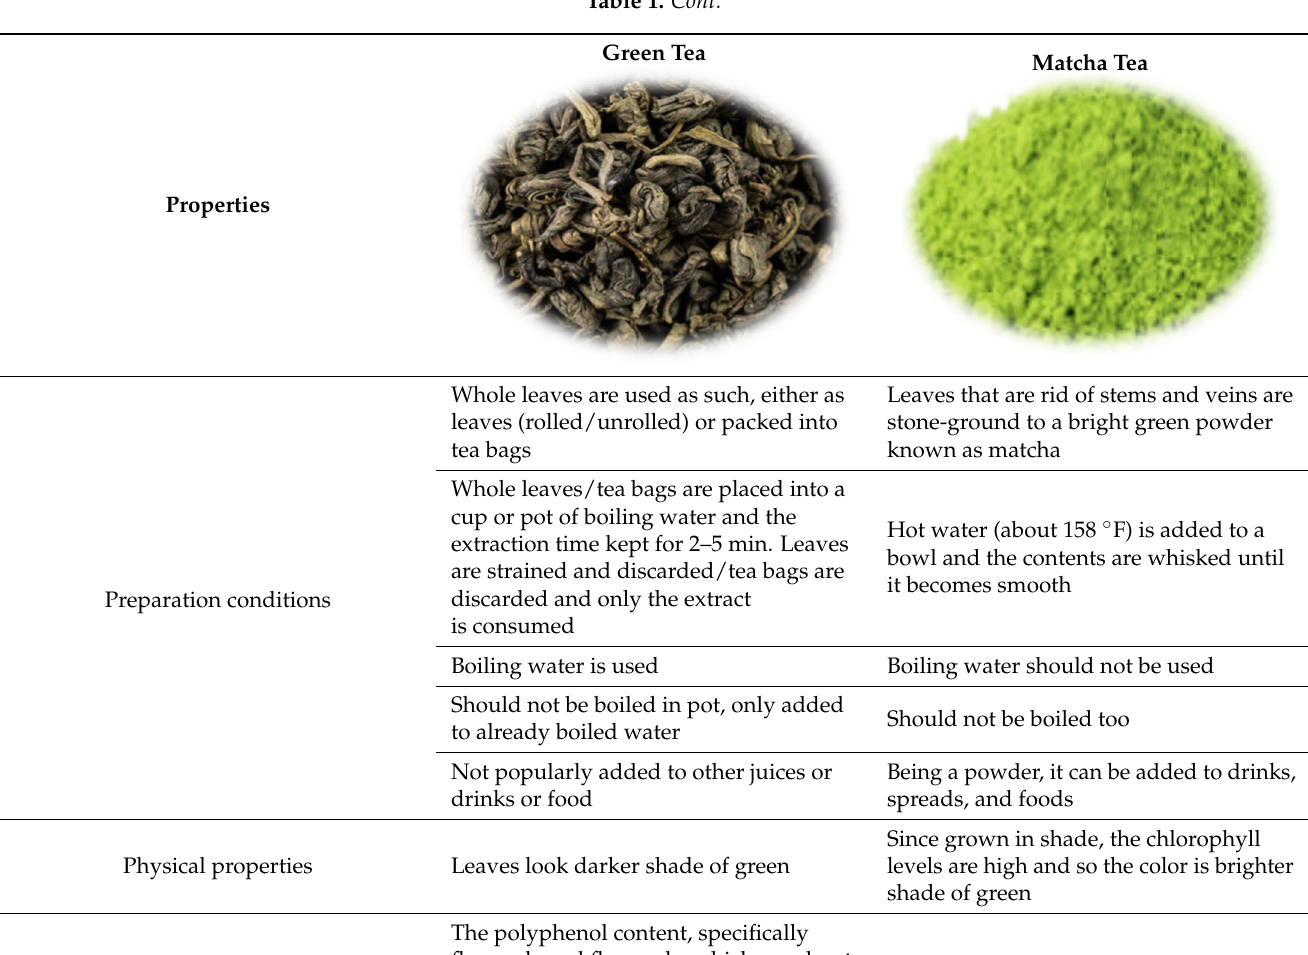
Table 1. Cont. Table 1. Comparative account of green tea versus matcha tea. Table 1. Comparative account of green tea versus matcha